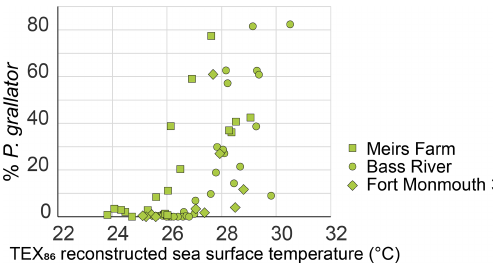
Figure 6. Relative abundances of Palynodinium grallator versus temperature. TEX 86 sea surface temperatures of ODP 174AX Bass River (Woelders et al., 2018) and Meirs Farm and Fort Monmouth 3 (Vellekoop et al., 2016) versus relative abundances of Palynodinium grallator (this study), for the uppermost Maastrichtian. Paleocene samples are not included in this cross plot.